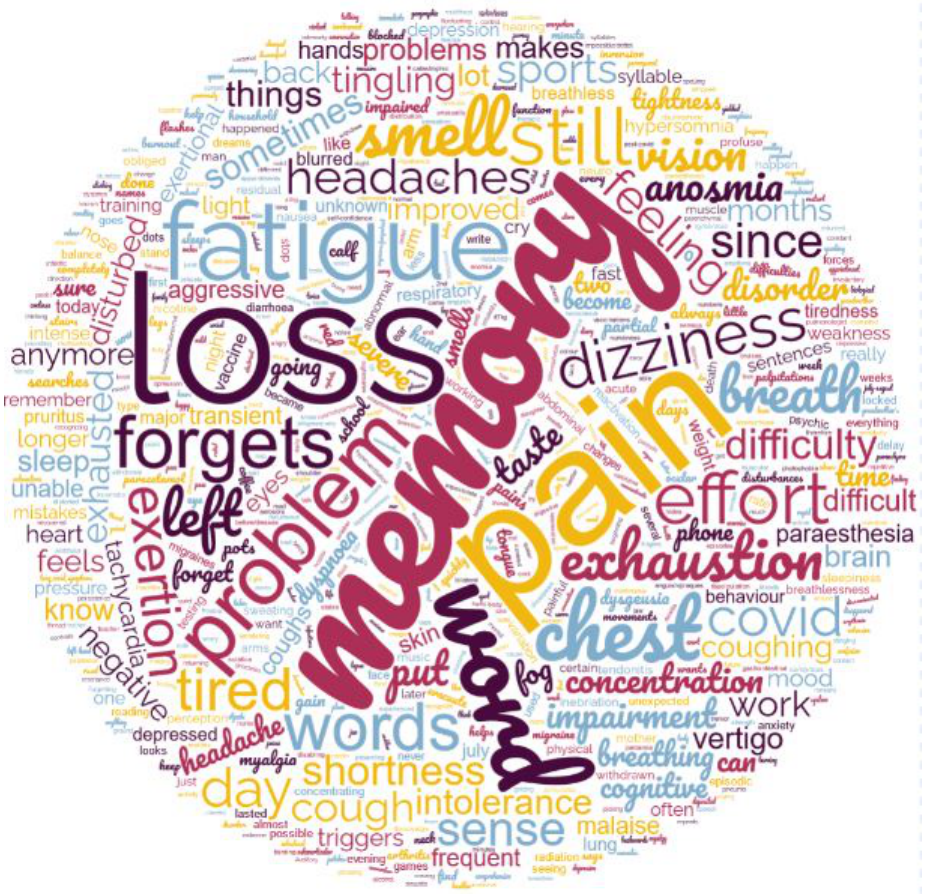
Figure 2. Patients express recurrent complaints. Here we have included all the complaints transcribed in English in the observation recordings of the first 34 patients seen in the family medical practice. This terminological view, edited in a word cloud (wordclouds.com), gives a conceptual representation of the clinical picture of PACS recorded by doctors. The size of the words gives an idea of